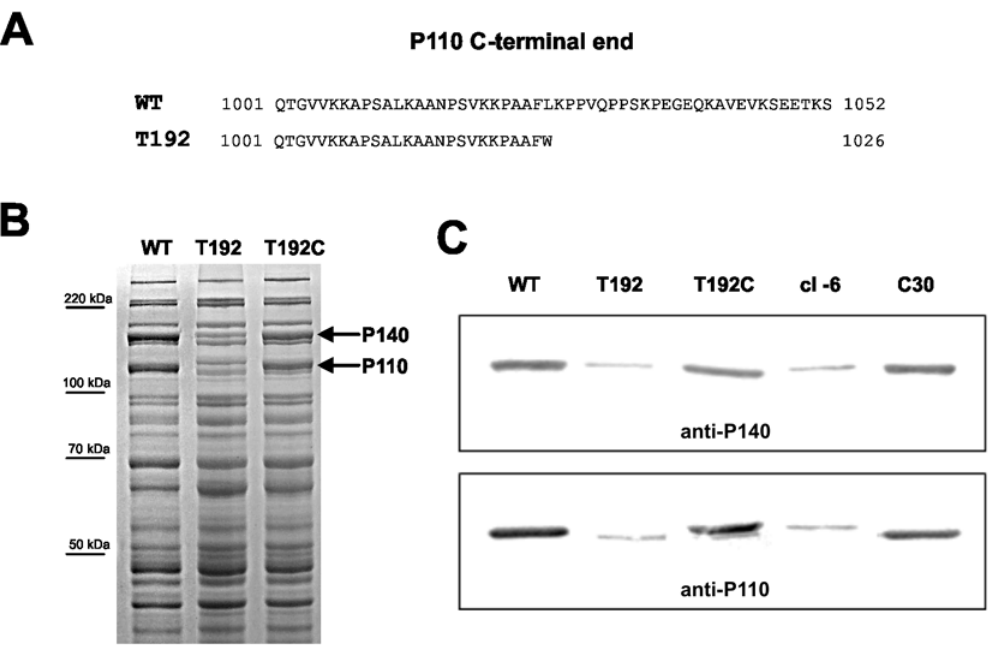
Figure 2. Analysis of P110 and P140 proteins. (A) Amino acid sequence of the P110 C-terminal end in the WT strain and the T192 mutant. (B) Protein profile of the WT strain and the mutants T192 and T192C by SDS-PAGE. (C) Western blotting analysis of the WT strain and the mutants T192, T192C, cI-6 and C30 using antiserum to P140 and P110.